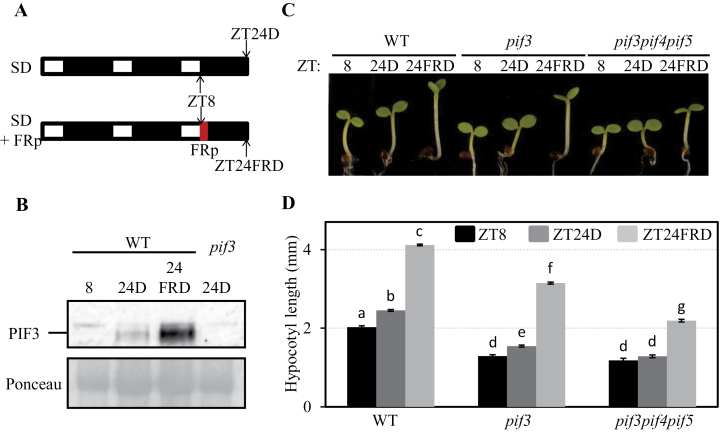
Inactivation of phytochrome activity by an EOD-FRp increases PIF3 accumulation and hypocotyl growth under SD conditions. (A) Diagram of the growth regime used for B–D. Seedlings were grown under SD conditions for 2 d and 8h, at which time (ZT8) they either were kept under SD and experienced a 16h night (ZT24D), or were given an EOD-FRp before the night period (ZT24FRD). (B) Immunoblot of protein extracts from WT seedlings at the specified time points. A PIF3-specific polyclonal antibody was used as probe. As an antibody specificity control, a protein extract from pif3-3 harvested at ZT24D was included. Ponceau staining was used as a loading control (bottom). n.s., non-speciﬁc cross-reacting bands. (C) Visual phenotype of WT, pif3, and pif3pif4pif5 seedlings grown as detailed in A. (D) Hypocotyl length in WT, pif3, and pif3pif4pif5 seedlings grown as detailed in A. Data represent the mean and SE of at least 20 seedlings. Different letters denote significant differences among means (P < 0.05). (This figure is available in colour at JXB online.)